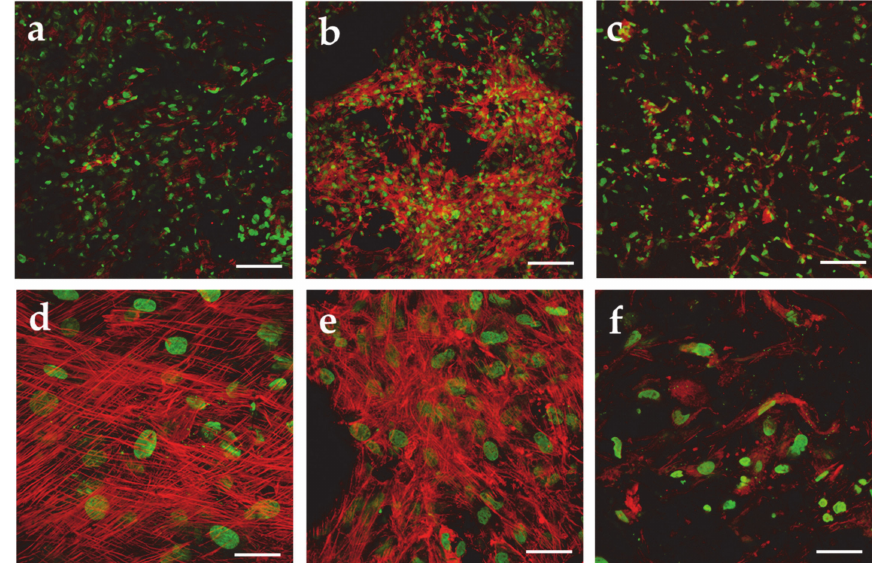
Figure 3. Confocal laser scanning microscopy (CLSM) analysis on hMSC / *PCL constructs how cell nuclei imaged in green and f -actin in red: ( a , d ) di ff erentiated in static conditions; ( b , e ) di ff erentiated in dynamic conditions; ( c , f ) undi ff erentiated. ( a – c ) Scale bar = 100 µ m, original Magnification 200 × ; ( d – f ) Scale bar = 30 µ m, original magnification 600 ×